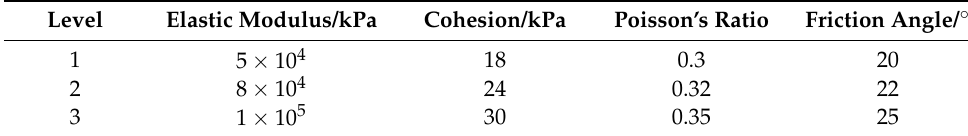
Table 2. Levels of factors.